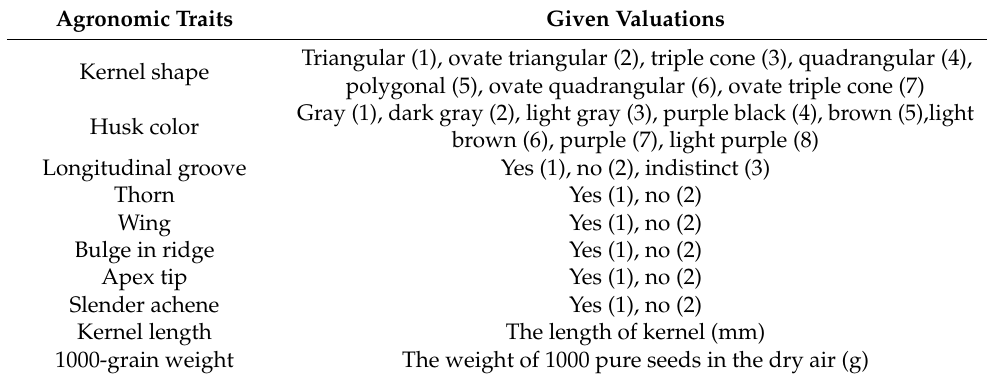
Table 1. The main morphological traits of Tartary buckwheat seeds and their given valuations. Agronomic Traits Given Valuations